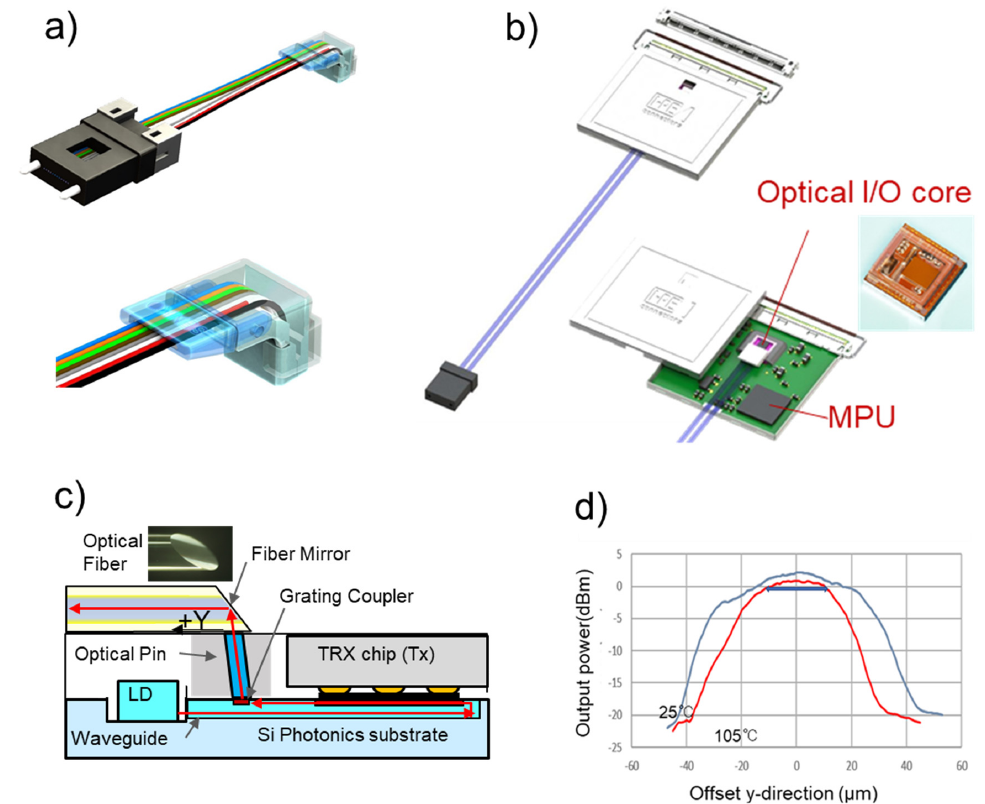
Figure 16. ( a ) Commercial vertical fiber array unit (courtesy of Senko); ( b ) electro-optically pluggable micro-transceiver module “EOB”; ( c ) cross-sectional schematic showing low-form factor coupling based on cleaved fiber; ( d ) misalignment tolerance of cleaved fiber at 25 to 105 °C